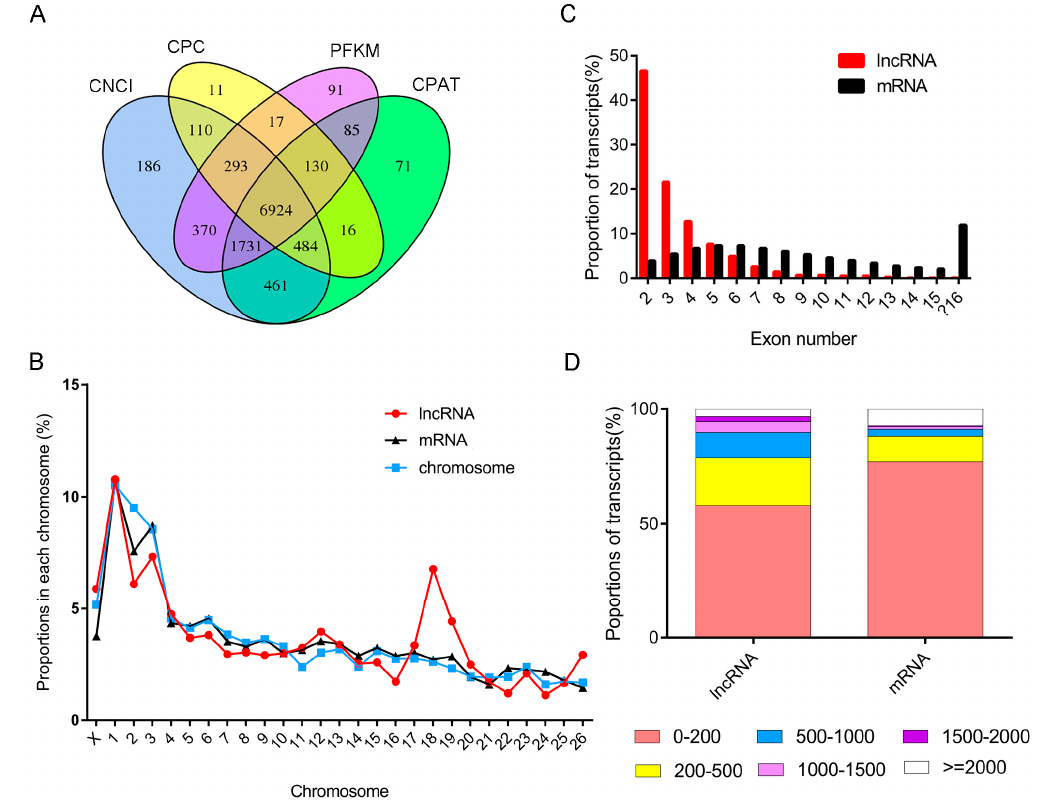
Figure 1. The features of sheep muscle long non-coding RNA (lncRNAs) and mRNAs. ( A ) Venn diagram of noncoding transcripts from the Coding Potential Calculator (CPC) [20], the Coding-Non-Coding Index (CNCI) [21], the Protein Families Database (PFAM) [22] and the Coding-Potential Assessment Tool (CPAT). ( B ) Distribution of lncRNAs and mRNAs along each chromosome. The red and black lines indicate the proportion of lncRNAs and protein-coding genes respectively, the blue line indicates the size proportion of the corresponding chromosome in the genome. ( C ) Exon numbers per transcript of sheep muscle lncRNAs. ( D ) Exon size distribution of sheep muscle lncRNAs.